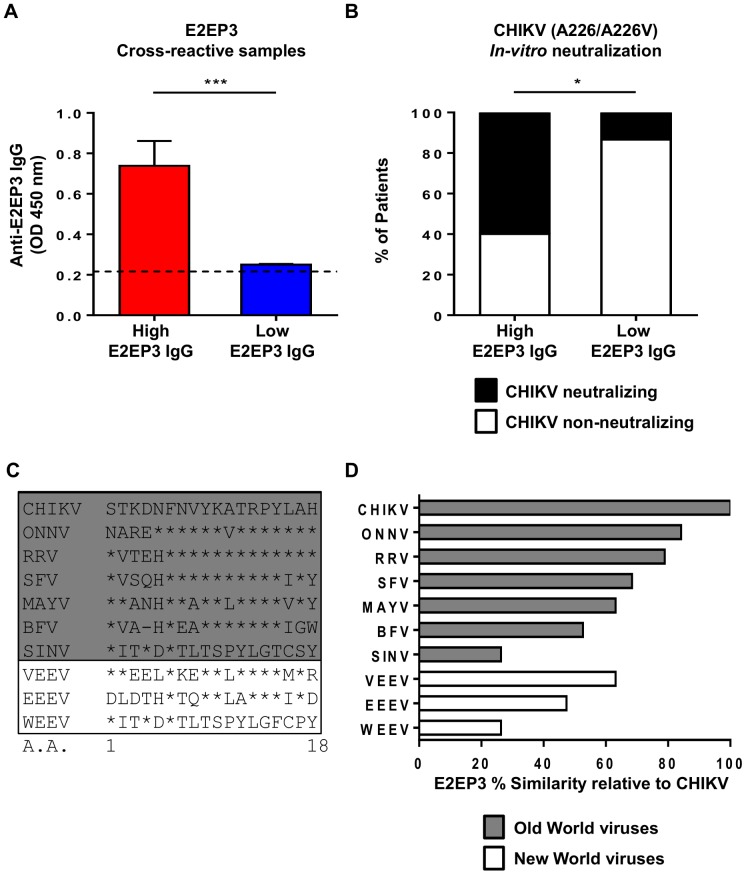
Association of E2EP3 cross-reactive antibody responses with CHIKV neutralizing activity.
A, Anti-E2EP3 antibody response in serum samples (High E2EP3 IgG responders, n = 10; Low E2EP3 IgG responders, n = 15), at a dilution of 1∶4,000 were determined by ELISA using biotinylated E2EP3 peptides. Data are presented as mean ± SEM. Data are representative of two independent experiments with similar results. Statistical significance was measured using Mann-Whitney U test (***P<0.0001). B, In-vitro neutralizing activity against CHIKV in High and Low E2EP3 IgG responders. Histogram shows the percentage of patient samples with or without CHIKV neutralizing activity. Statistical significant was measured using 2-sided Fisher exact test between the patient samples with and without CHIKV neutralizing activity in the 2 responder groups. *P = 0.028. C - D, E2EP3 sequence from CHIKV was aligned to corresponding sequences from 9 non-CHIKV alphaviruses (ONNV, RRV, SFV, MAYV, BFV, SINV, VEEV, EEEV and WEEV). Conserved amino acid (A.A.) are indicated by a *. Percentage similarity between CHIKV E2EP3 sequence and corresponding sequence from each non-CHIKV alphavirus were calculated with SIAS (http://imed.med.ucm.es/Tools/sias.html). Percentage similarity relative to CHIKV E2EP3 is indicated by a bar-chart. Viruses classified as Old World alphaviruses are marked by the grey shading box, while viruses classified as New World alphaviruses are marked by the white box. NCBI Genbank accession numbers of ten selected alphaviruses (CHIKV - DQ443544, ONNV - O90369, RRV - AEC49728, SFV - ABA29033, MAYV - AAL79764, BFV - NP819000, SINV - ACU25462, VEEV - AAB02519, EEEV - NP740646, WEEV - NP818940).